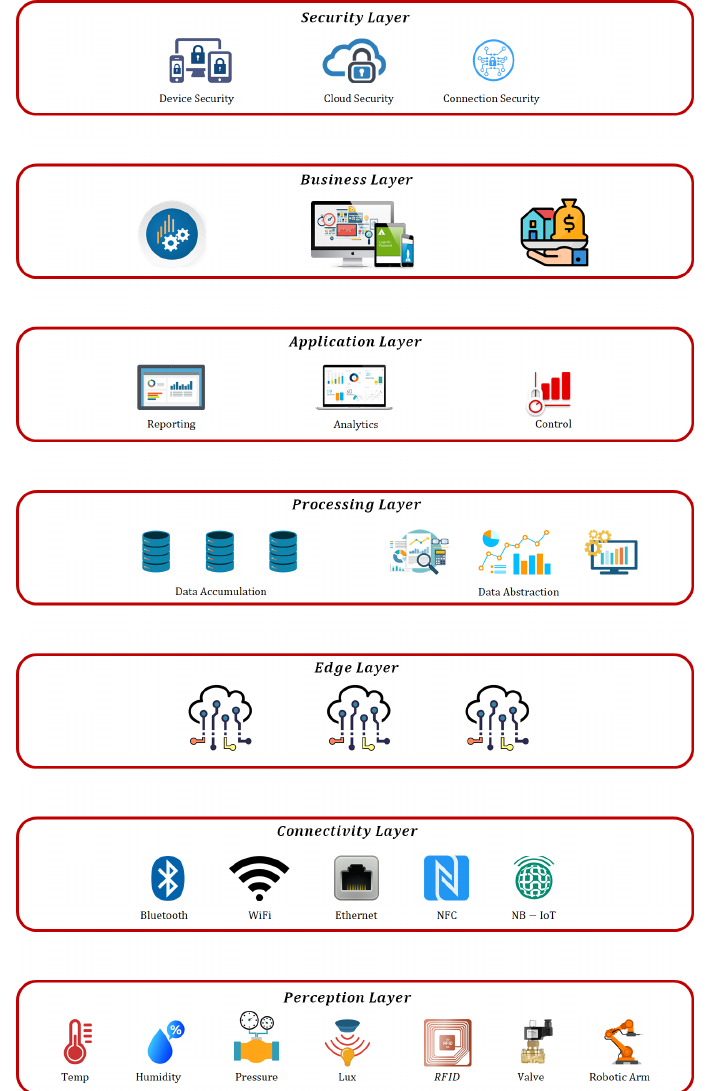
Figure 3. Reference architecture of the Industrial Internet of